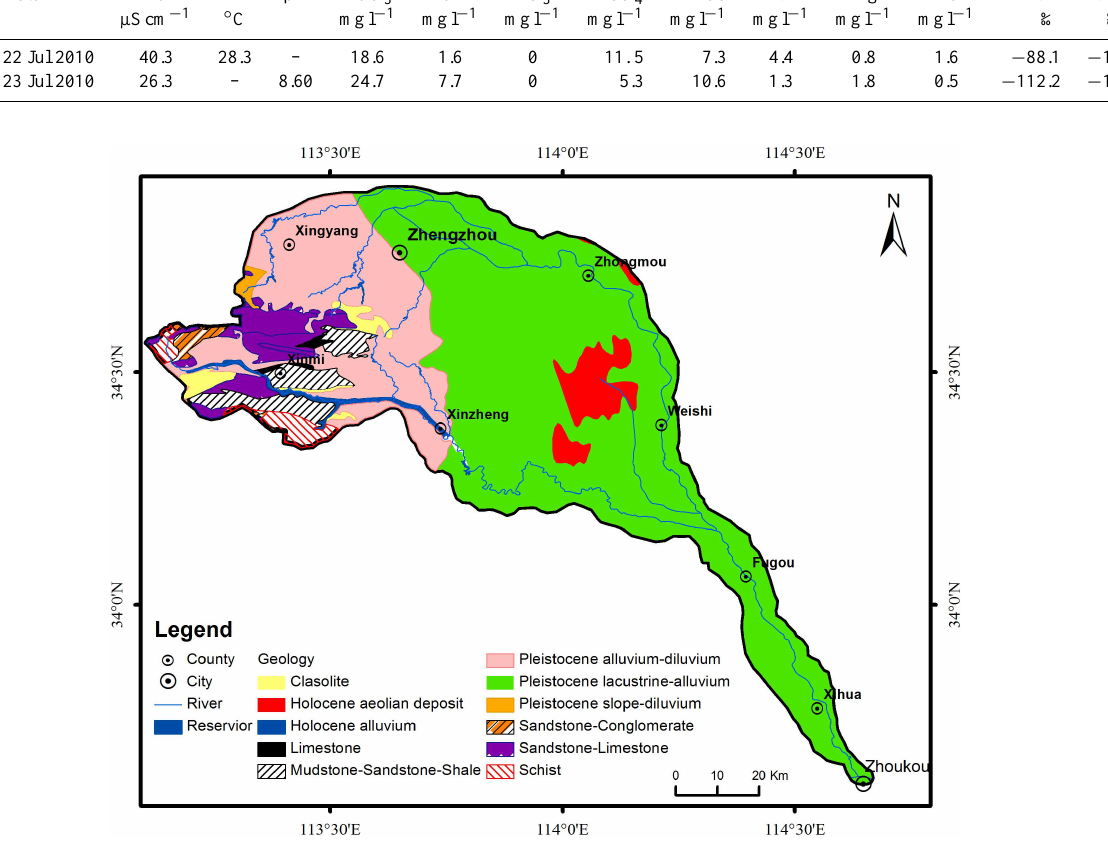
Fig. 3. Major geological formation of the study area (data source: